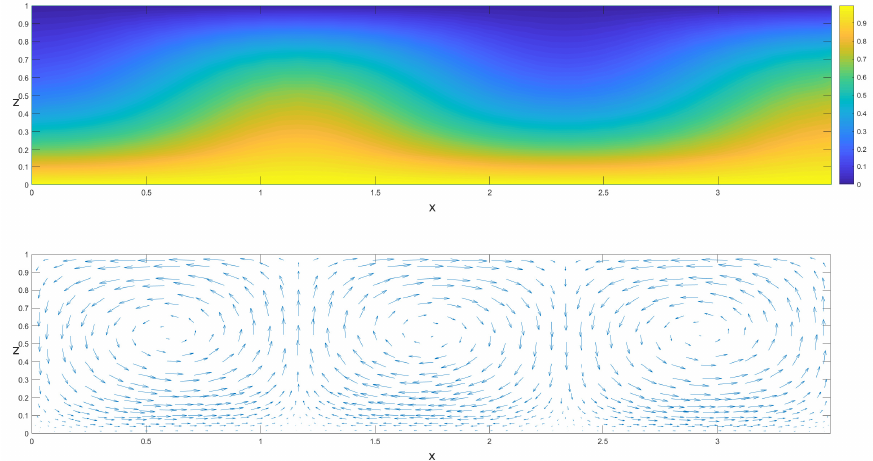
Figure 3. Isotherms and velocity field of the numerical solution obtained with finite elements; R = 1300 and Γ = 3.495.